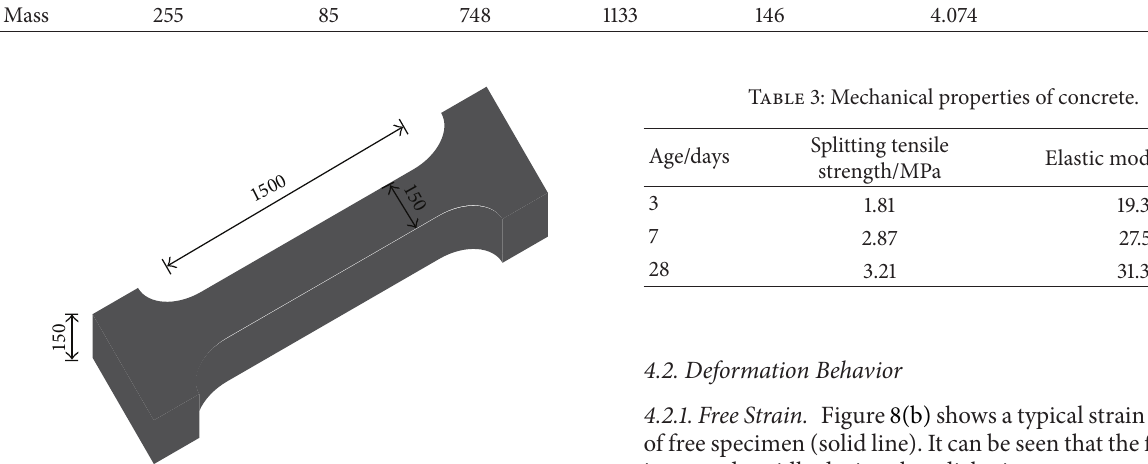
Figure 7: Dimensions of the TSTM specimen (mm).